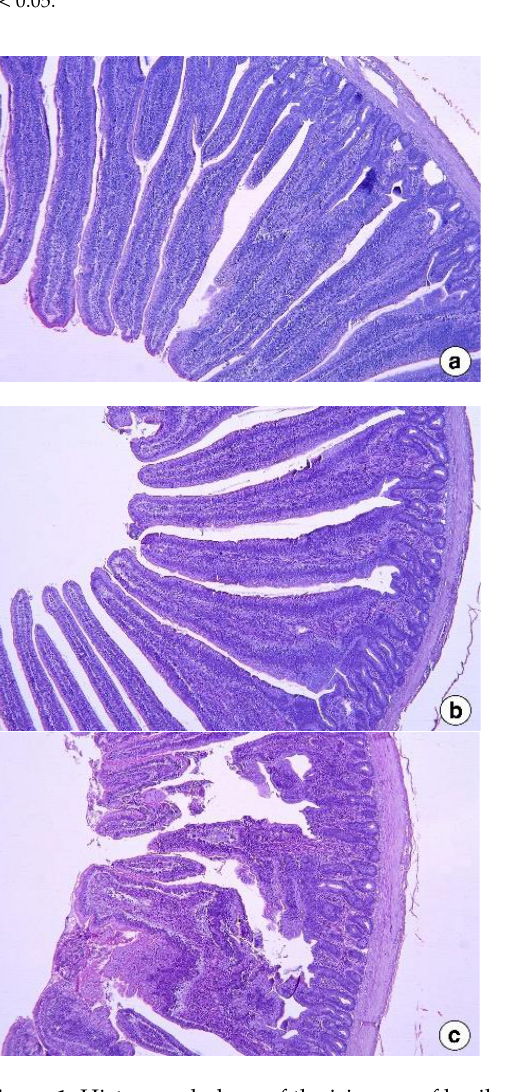
Figure 1. Histomorphology of the jejunum of broilers at 42 days of age from the control group ( a ), FS5 group ( b ), and FS10 group ( c ) (H & E stain, ×50 magnification).